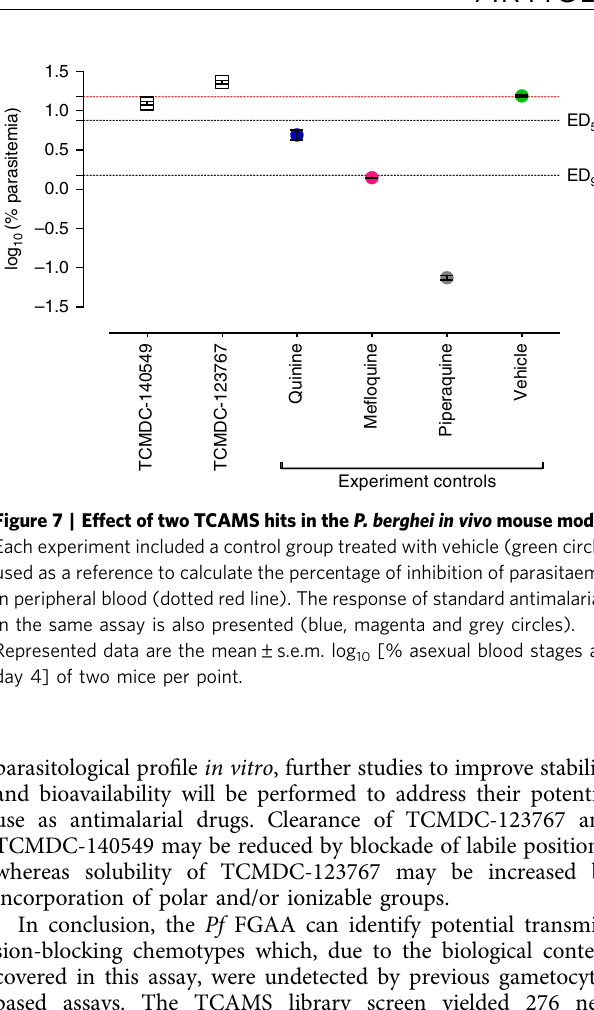
for further progression, while other hits represent valuable starting points as tool compounds to identify new modes of action involved in the biology of Plasmodium transmission.